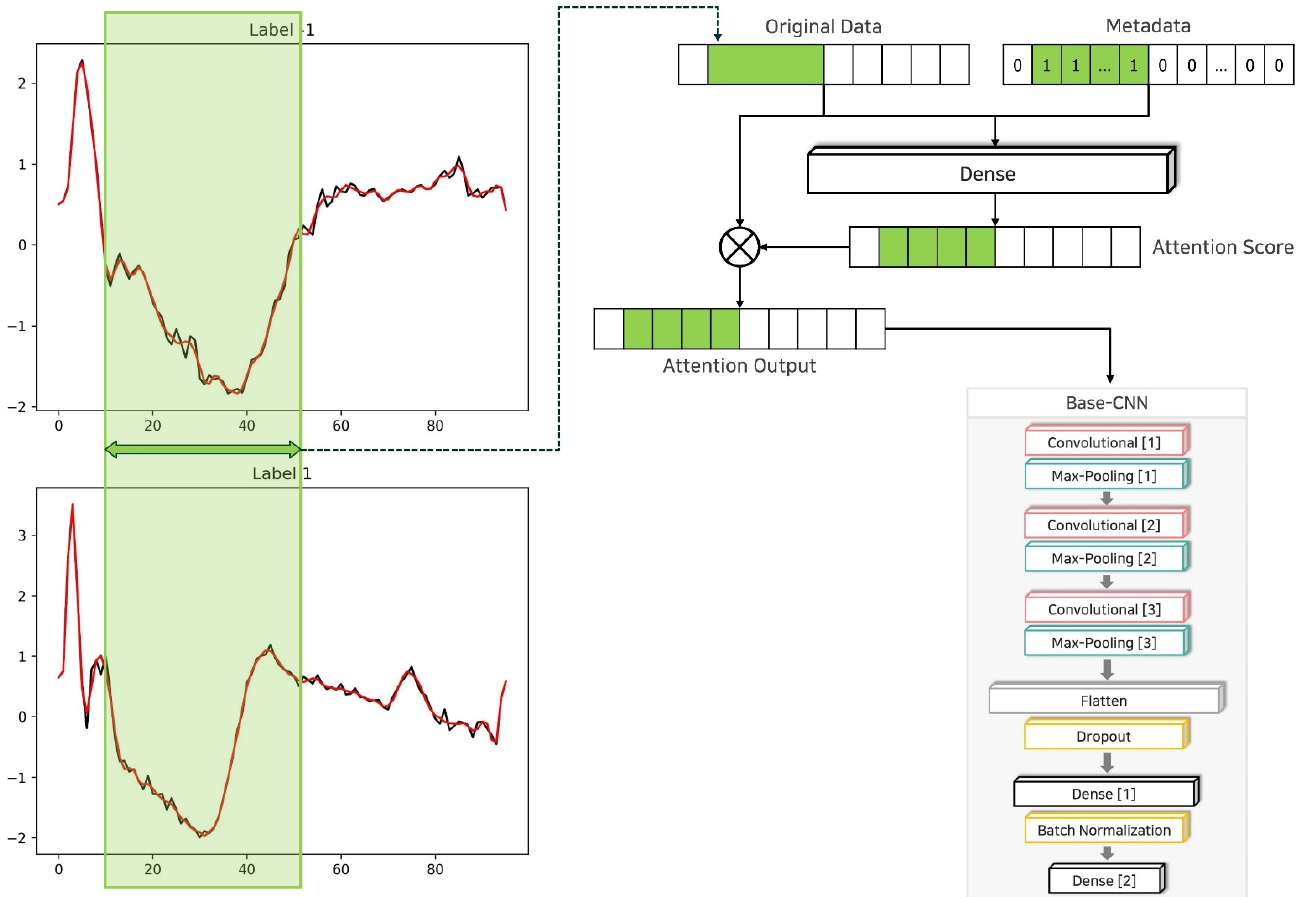
Figure 4. T wave part as shallow domain knowledge (green) and SDK-Injecting attention. The sample patterns are for the diagnosis of ischemia. The fact is known that the shape of the T wave is one of the main criteria for the diagnosis of ischemia. Therefore, the range of the T wave part (green) is used as shallow domain knowledge and injected by SDK-Injecting attention.